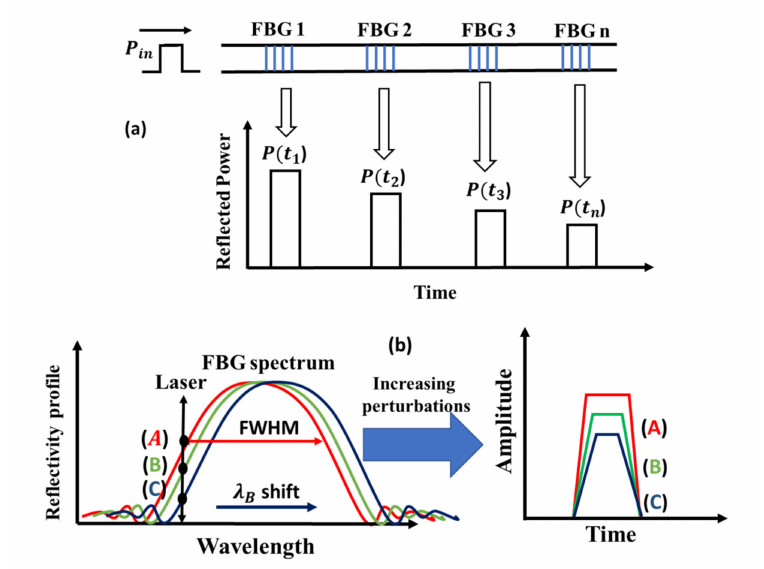
Figure 1. ( a ) Signal representation in TDM-FBGs; ( b ) the translation of Bragg wavelength shift into amplitude variations in TDM-FBG